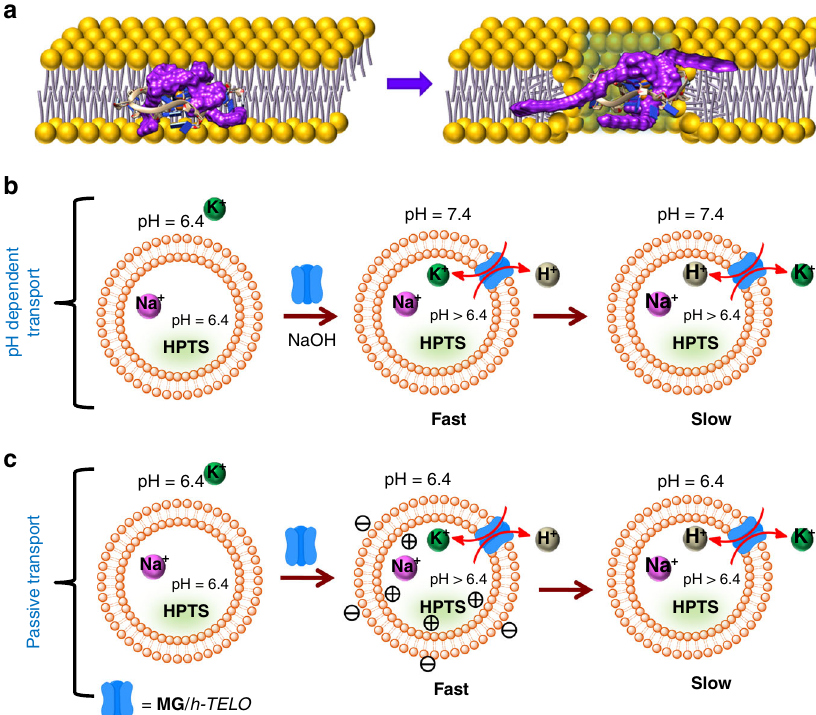
Fig. 5 Proposed mechanism for ion transport in fl uorescence assay. Schematic representation showing a the formation of water- fi lled ionophore in the lipid bilayer by rearrangement of lipid molecules upon insertion of MG / h-TELO . The lipophilic chains of MG anchors the MG / h-TELO to stabilize the ionophore. b The stepwise ion transport (left to right) by pH-dependent transport (top) and; c passive diffusion